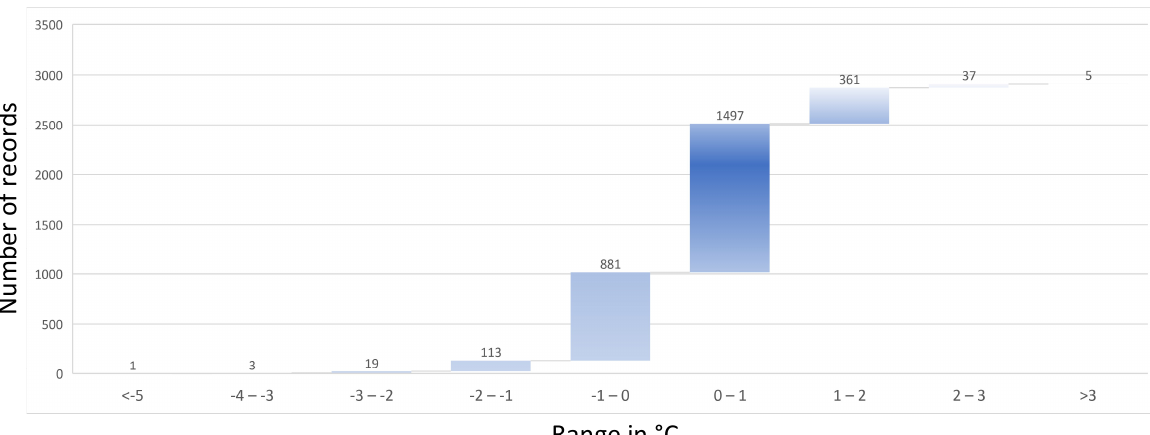
Figure 16. Presentation of MASE-based and RMSE-based and Willmott’s-based training curve. The Records’ deviation in Figure 17, and the real temperature versus predicted are plotted in Figure 18. The prediction of our LSTM model is plotted for 1 month, 1 year, and 8 years from April-2013 till April-2021. The prediction values are based on a trained model with 32 years of historical data, which possibly captures the ongoing effects of climate change. The visual comparison in Figure 18 shows that the LSTM model is performing well. The prediction trends follow almost the training trends in the overall plot with a mean of residual values over the 8 years around 0.59 °C. Further details on model validation are presented in Supplementary Part VI (see Supplementary Materials).